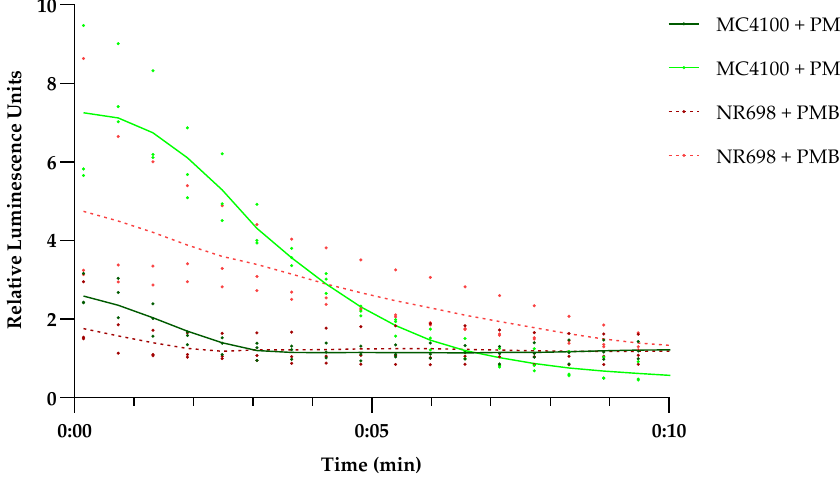
Figure 5. Effect of PMB and PMBN on plasma membrane integrity of E. coli MC4100 and NR698. Luminescence kinetics of LucGR in E. coli MC4100 (solid shades of green) and E. coli NR698 (dashed shades of red) in response to the presence of 12.5 µg/mL PMB (light color) or polymyxin B nonapep- tide (PMBN) (dark color) and due to D-luciferin influx caused by plasma membrane permeabilization. The data points represent three independent measurements normalized to the negative control in the presence of D-luciferin only. The mean is represented by the solid line of the same color. An initial luminescence increase represents membrane permeabilization, the subsequent luminescence decrease represents ATP depletion due to bacterial cell death because of lost membrane integrity, while luminescence stabilization on the level of the control indicates survival of the main population with limited or no plasma membrane